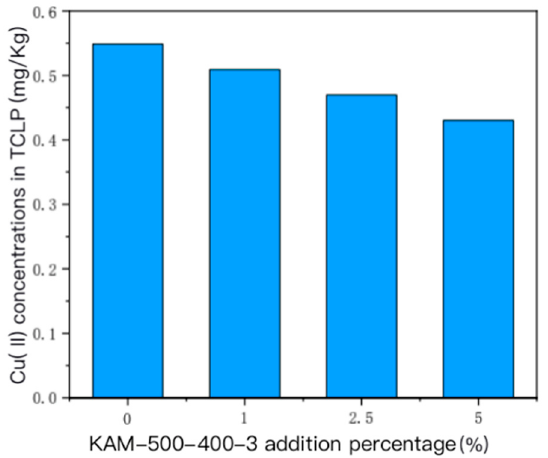
Figure 7 . Fraction of Cd(II) in Cu(II)–Cd(II) mixed contaminated sediment determined through BCR sequential extraction under different addition percentages of KAM500-400-3.